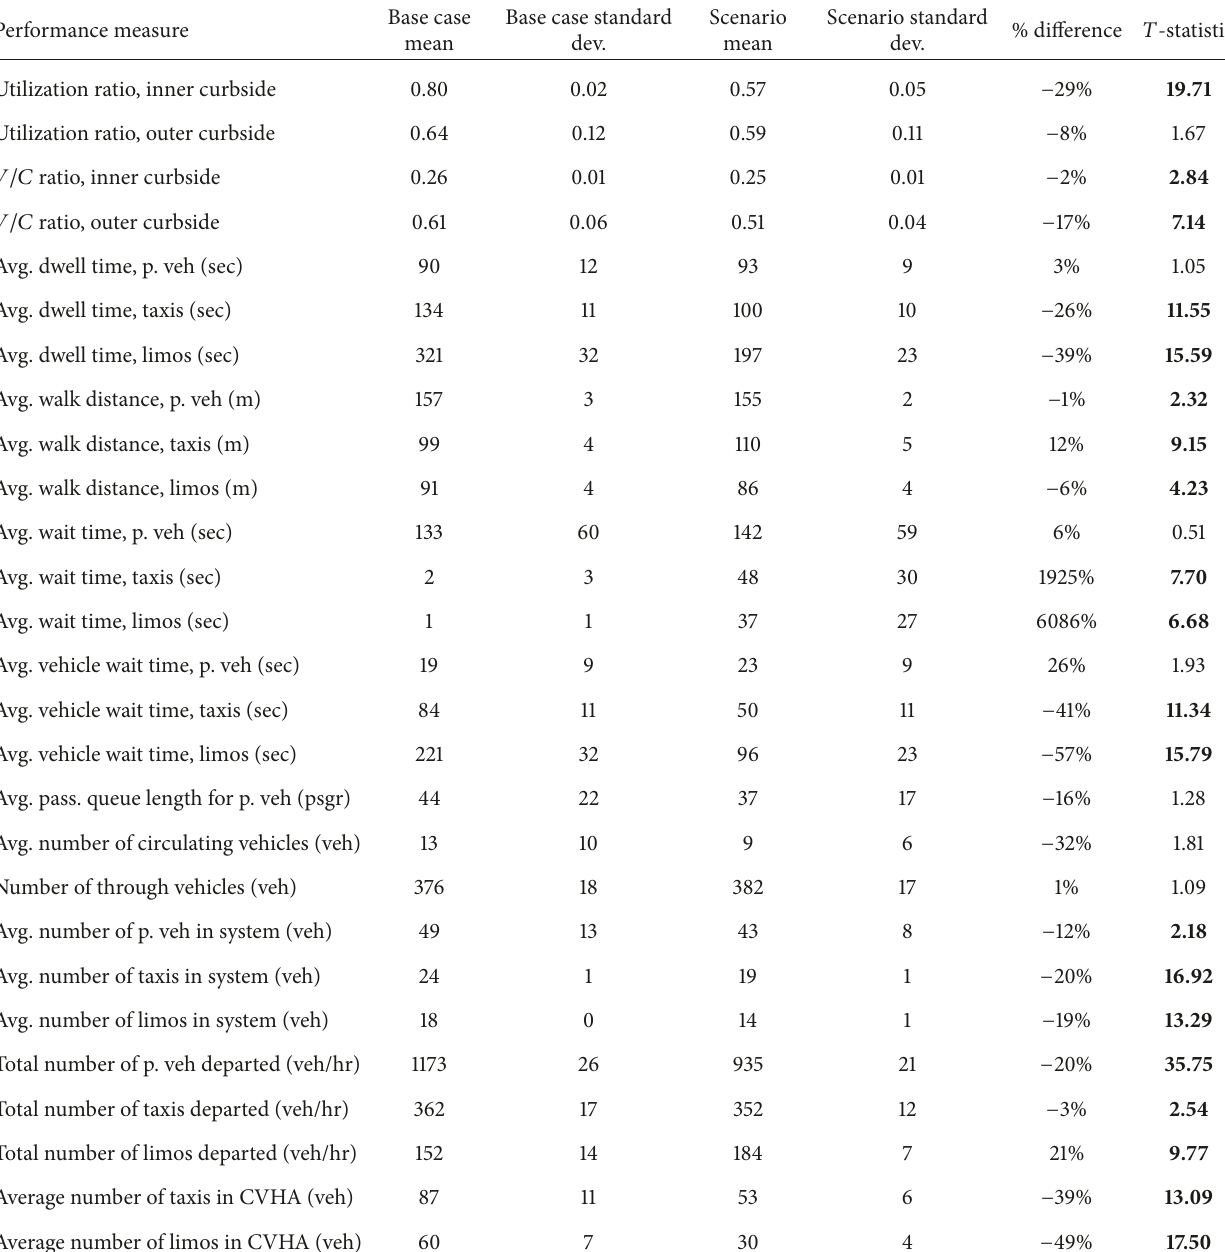
Table 6: Results for inclement weather scenario (bold cells indicate that result is significantly different from the base case). Performance